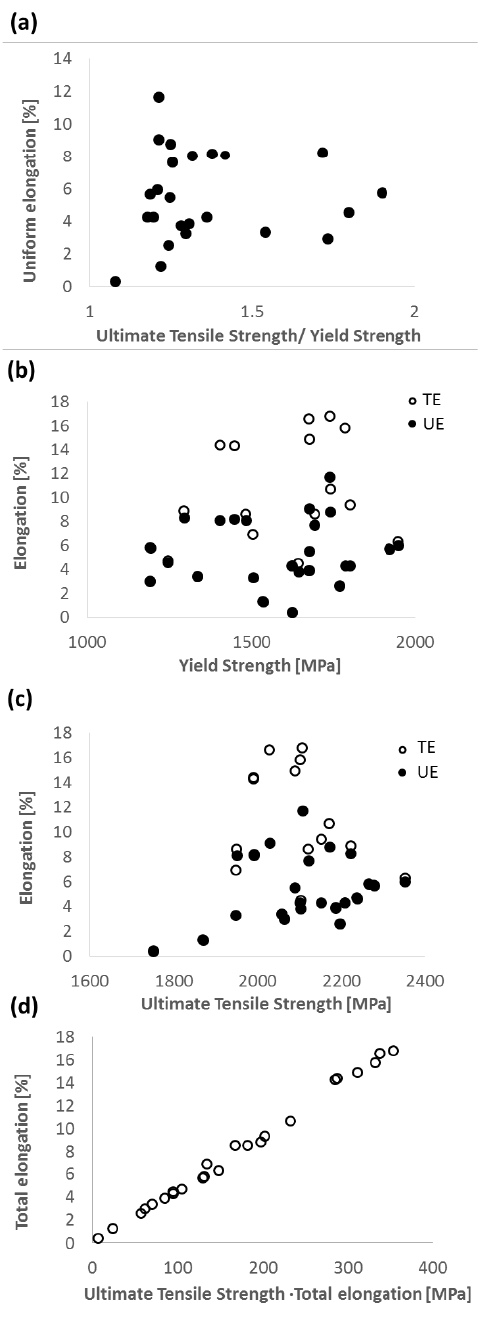
Figure 5. Correlation between strength and elongation (TE, total elongation; and UE, uniform elongation) parameters of different nanostructured bainites, from data from reference [53]. ( a ) UE vs. the ratio between ultimate tensile strength and yield strength; ( b ) elongation (TE and UE) vs. yield strength; ( c ) elongation (TE and UE) vs. ultimate tensile strength; ( d ) TE vs. the product between TE and ultimate tensile